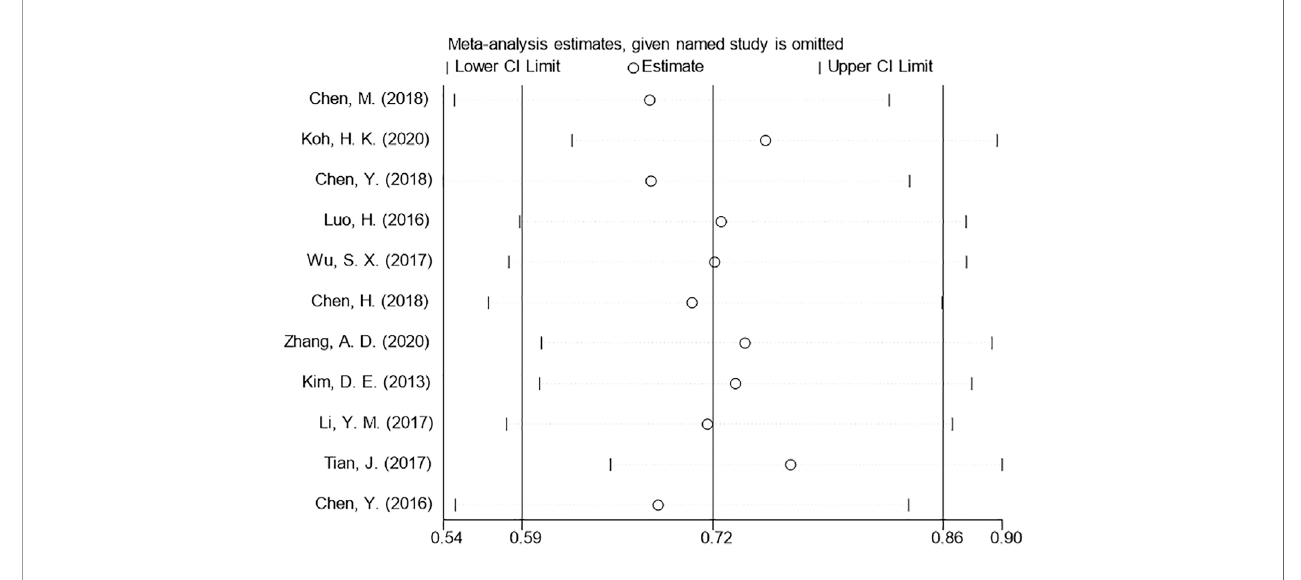
FIGURE 5 | Sensitivity analysis of HRs of OS. HR, hazard ratio.